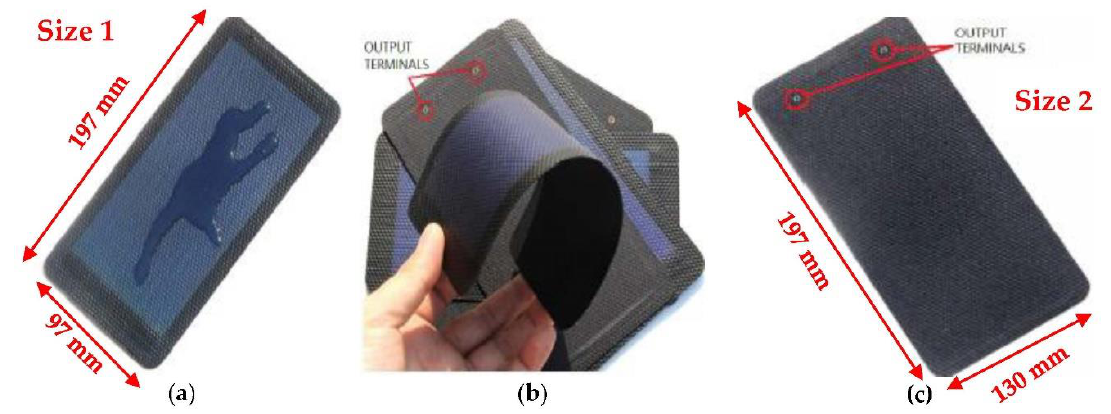
Figure 4. Top ( a ) and bottom ( b ) views of the flexible solar panel for the Size 1 typology, and bottom view of the flexible solar panel for the Size 2 typology ( c ).